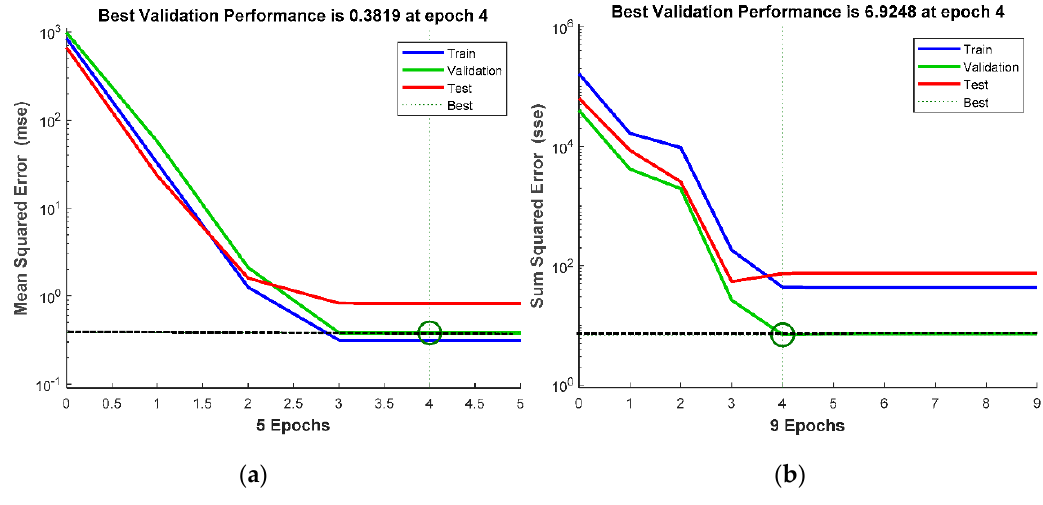
Figure 5. Performance of neural network regression during training: ( a ) Mean squared error; ( b ) Sum squared error.